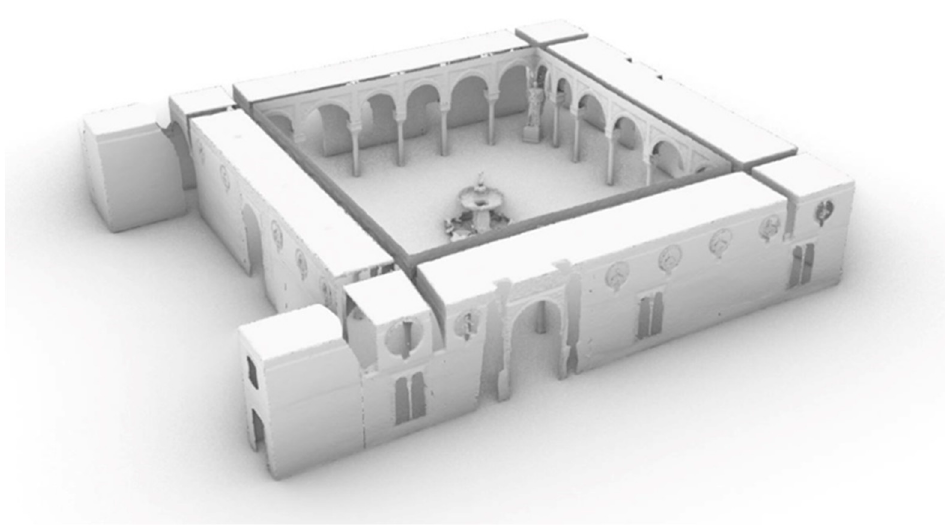
Figure 15. Study model of the Casa de Pilatos patio in ArchiCAD.